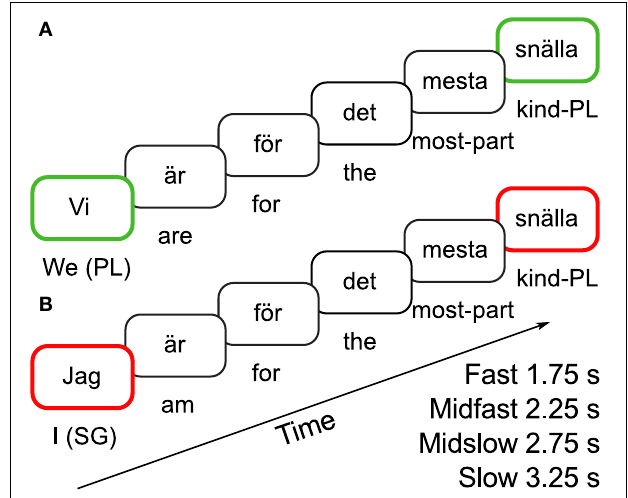
FIGURE 1 | Example sentences showing (A) agreement and (B) disagreement between grammatical subject and sentence-final predicate adjective, as well as the time intervals between subject pronoun and predicate adjective resulting from the different rates of word